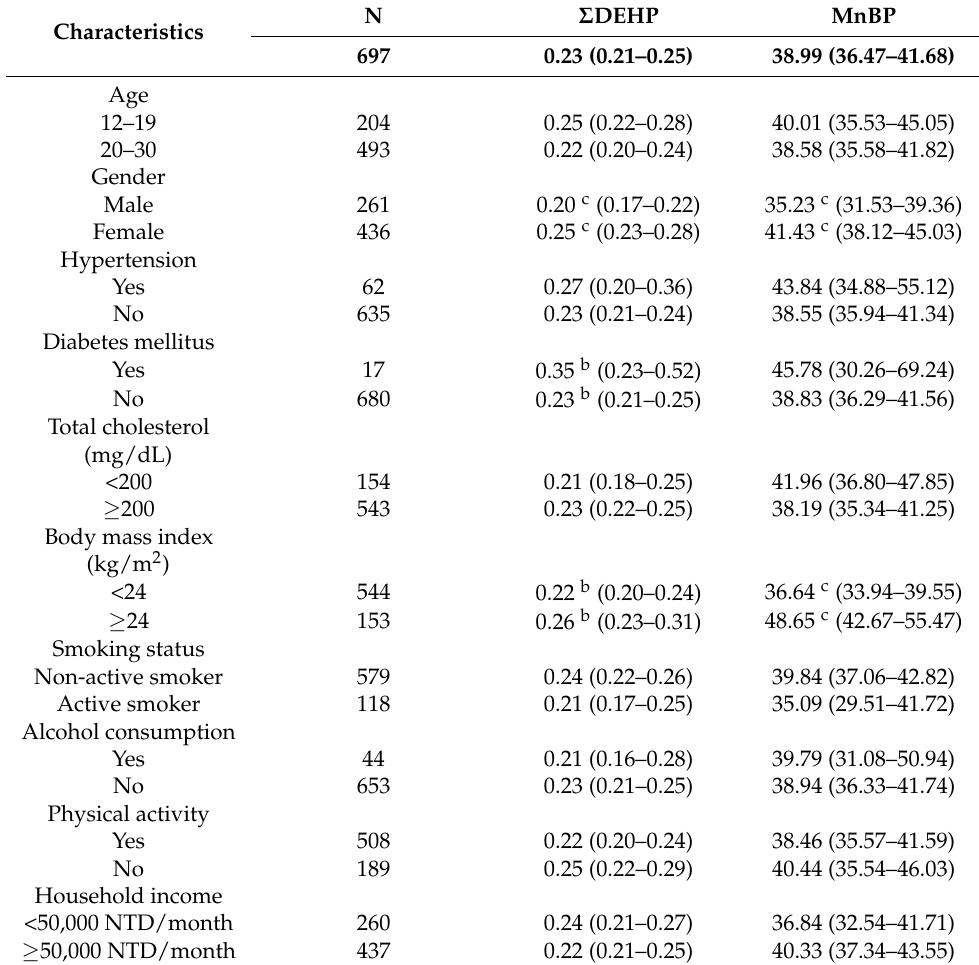
Table 1. Basic characteristics of the sample subjects including geometric mean and 95% confidence interval of the creatinine-adjusted urinary Σ DEHP and MnBP a .